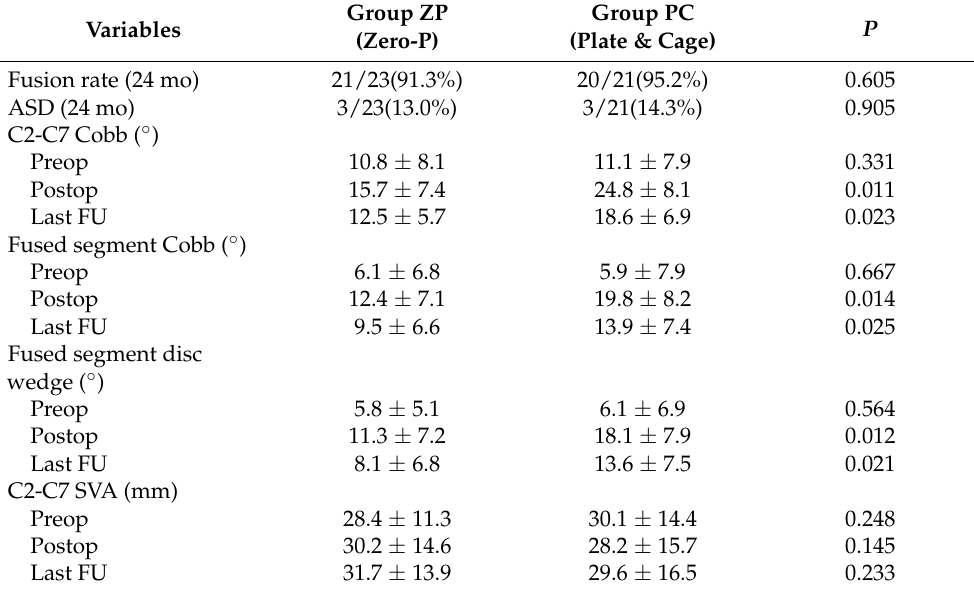
Table 4. Radiological outcomes of